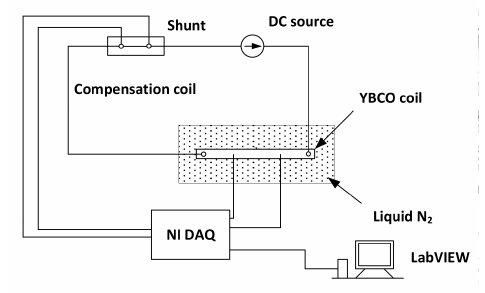
Figure 3. Critical current measurement circuit.